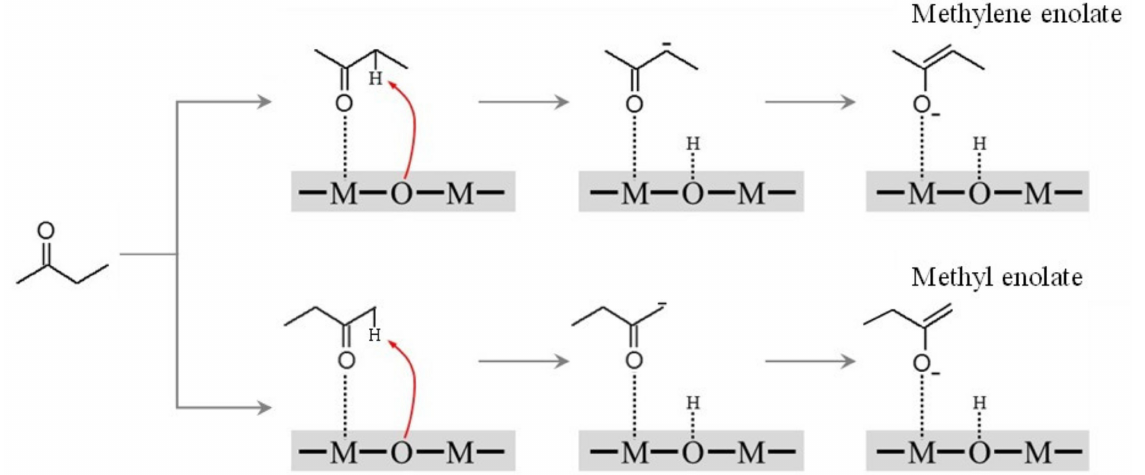
Figure 3. Formation of methyl and methylene enolate ions of 2-butonone on medium basic site of metal oxide